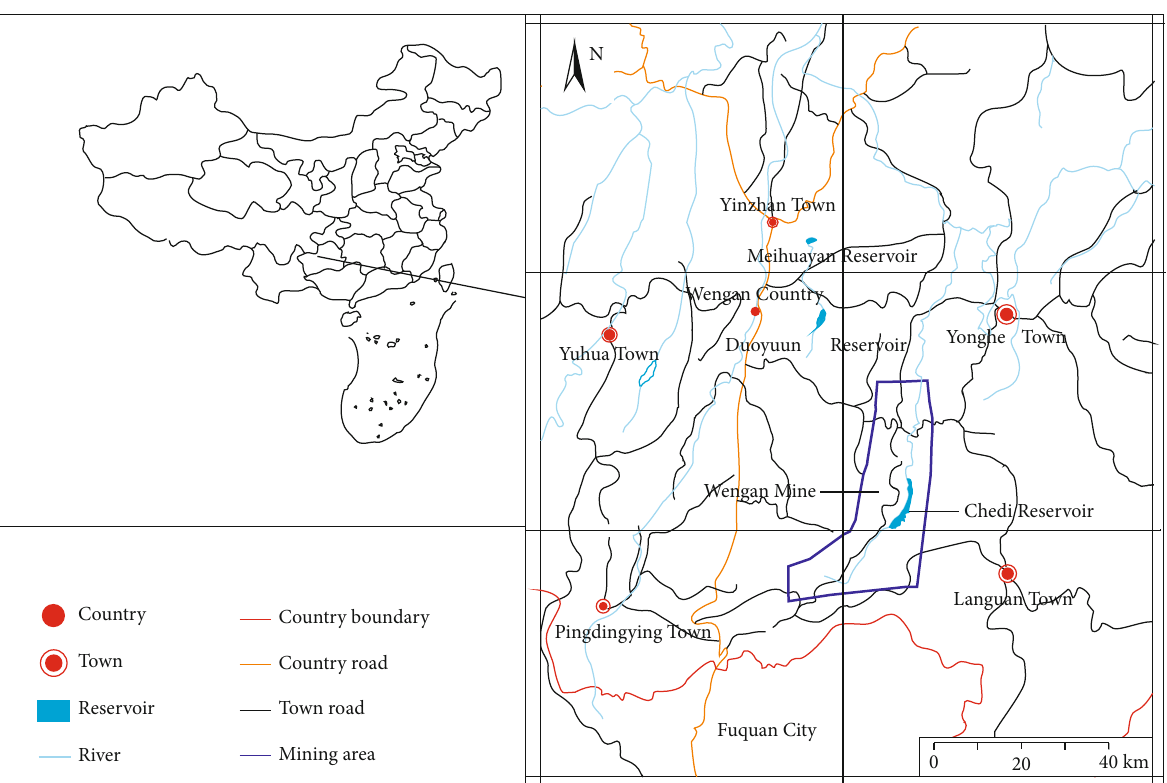
Figure 1: Geography